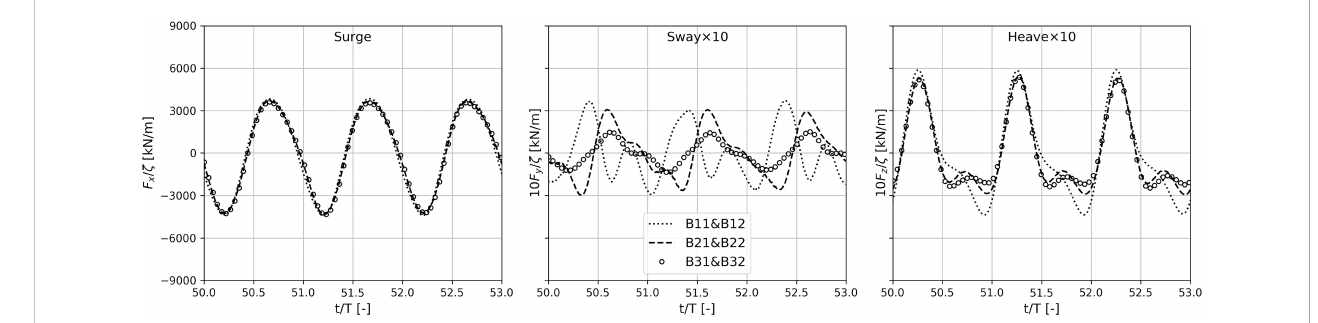
FIGURE 10 Time series of computed force acting in the joints connecting the modules at R1 and R2 in aregular wave of w = 0.33